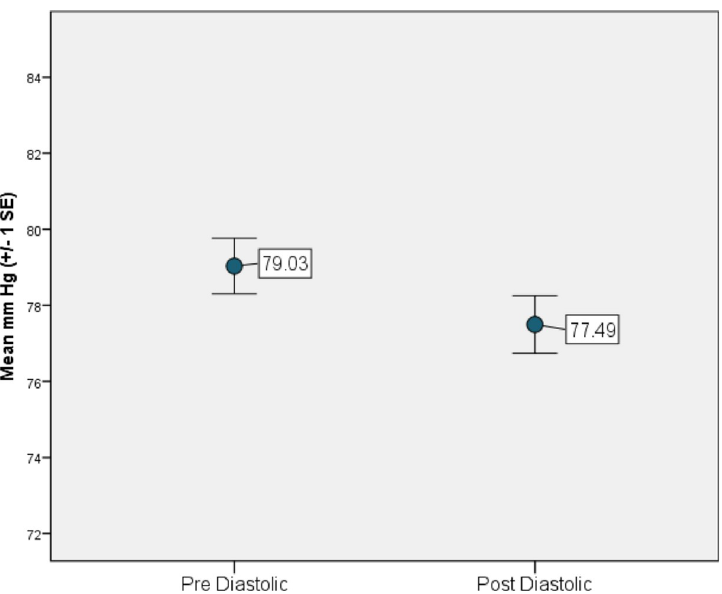
proportion of participants in the normal systolic blood pressure category post-River’s Edge experience (51%) compared to pre-River’s Edge experience (41%) (Fig 3). Additionally, there was a decrease in the proportion of participants in the normal diastolic blood pressure cate- gory post-River’s Edge experience (61%) when compared to pre-River’s Edge experience (53%) (Fig 4). However, the changes in proportions were found to be non-significant.